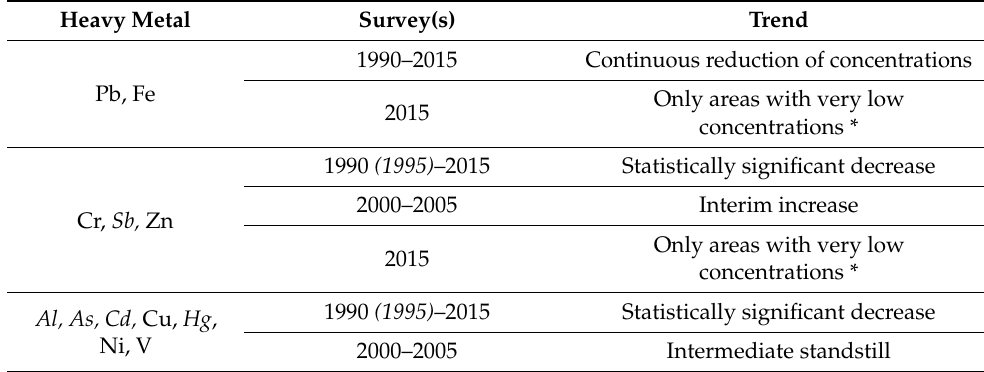
Table 3. Element-specific trends of heavy metal (HM) bioaccumulation in moss (Germany, 1990–2015). Heavy Metal Survey(s) Trend 1990–2015 Continuous reduction of concentrations Pb, Fe Only areas with very